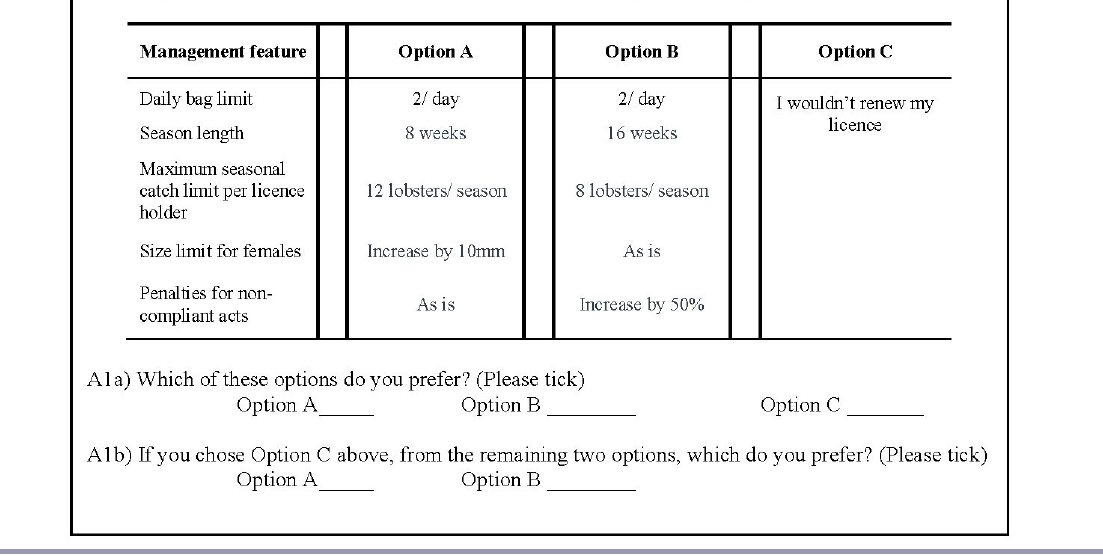
Fig. 2 . Example choice set given to